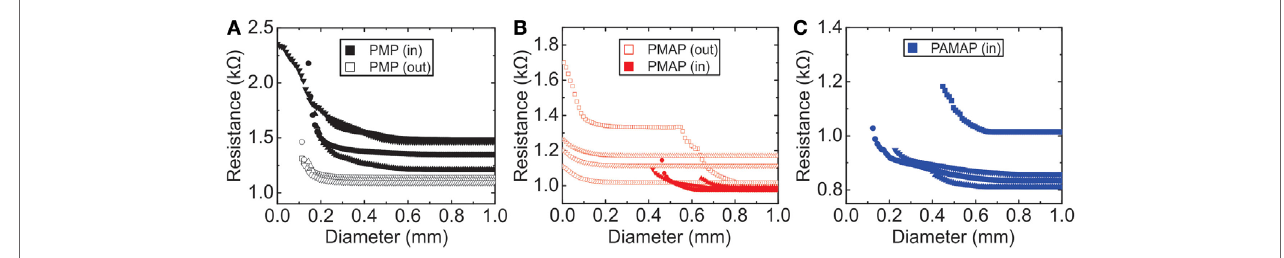
FigUre 7 | resistance data from (a) PMP, (B) PMaP, and (c) PaMaP minimum bend diameter tests . Minimum bending diameter was defined as the resistance measurement closest to 0 mm not measured as an open